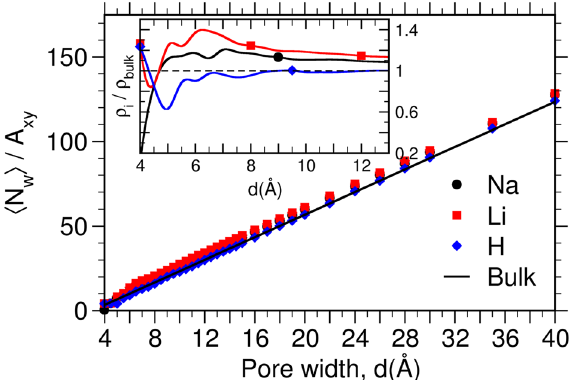
Figure 2. Number of water molecules adsorbed ( N W ) per unit area of the mica surface ( A xy ) in (black circle) Na-, (red square) Li-, and (blue diamond) H-mica pore at various pore widths ( d ). The solid line is the number − 3 based on bulk density of water (i.e., ρ b = 0.0334 Å ). Inset shows the significant deviations in density of confined water ( ρ i normalized by ρ b ) at smaller d .